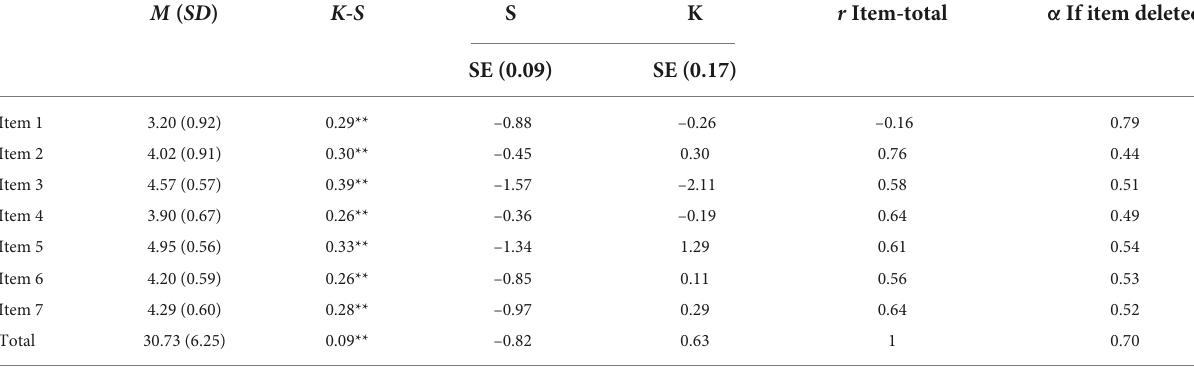
TABLE 2 Descriptive statistics, skewness and kurtosis indices, and item analysis for AS.